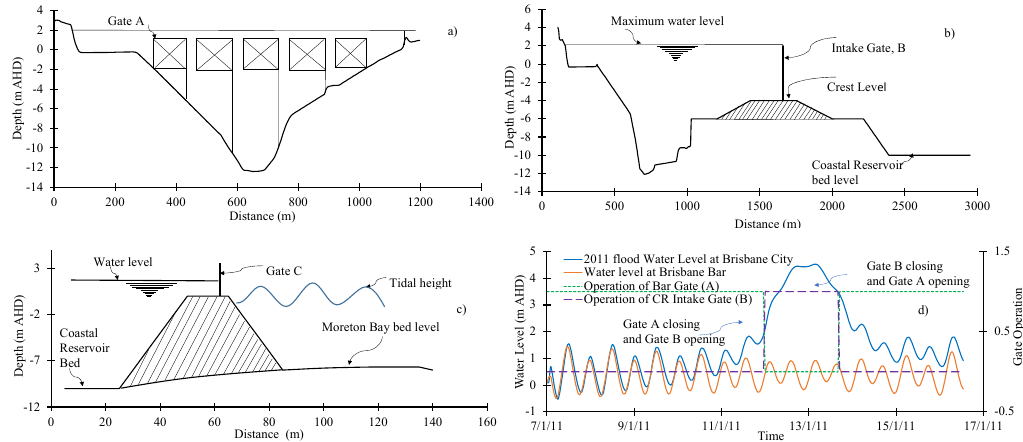
Figure 5. Schematics of gates: ( a ) Section A-A, Brisbane bar gate, A; ( b ) Section B-B, River mouth and CR intake gate, B; ( c ) Section C-C, Dike and outlet gate, C; ( d ) Gates operation for the 2011 flood event.